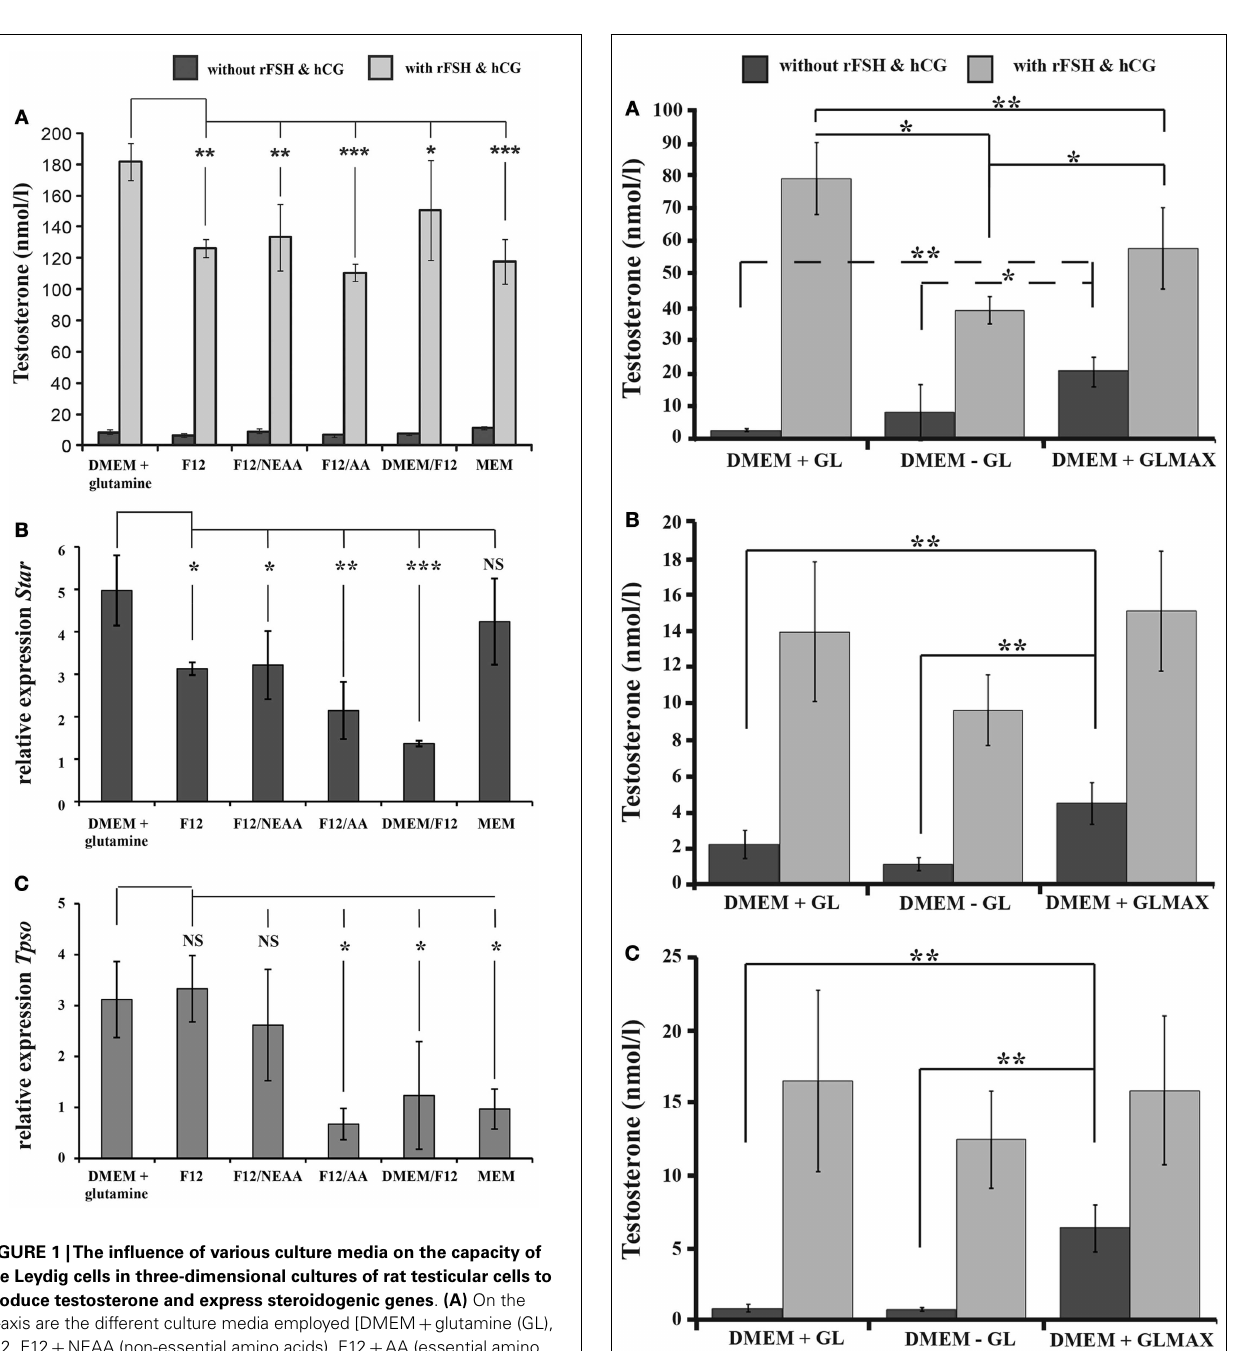
FIGURE 2 |The influence of different DMEM culture media on testosterone production by the Leydig cells in three-dimensional cultures of rat testicular cell .The cells were cultured for 14days in DMEM + glutamine (GL), DMEM − glutamine (GL), or DMEM + Glutamax (GLMAX) (presented on the X -axis) either with (light columns) or without (dark columns) hCG and rFSH stimulation.The concentration of testosterone in the culture medium following 1day (A) , 7days (B) , and 14days (C) of culture (determined by radioimmunoassay and expressed in nanomoles/liter) is shown on the Y -axis. One-way RM ANOVA with the Shapio–Wilk test for normality was applied to compare the different experimental conditions. * p < 0.05, ** p <